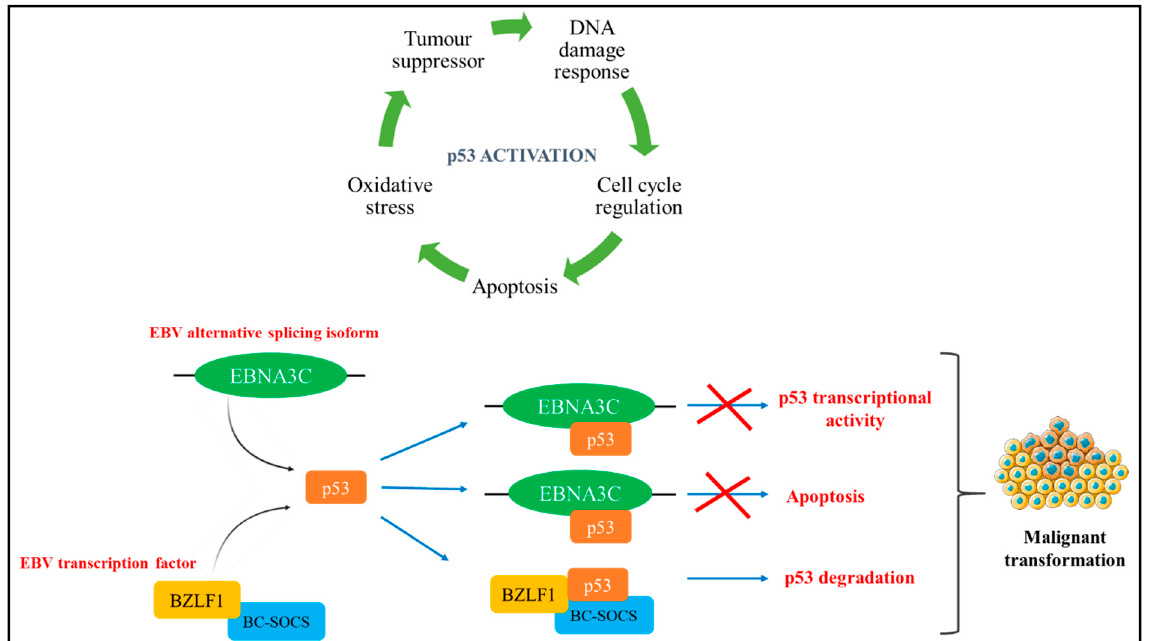
Figure 4. Epstein–Barr virus (EBV) isoform interaction with p53. The EBV spliced isoforms EBNA3C and the transcription factor BZFL1 both interact with p53 to induce oncogenic transformation such as apoptosis, inhibiting the transcriptional activity and degradation of p53 [62,63].